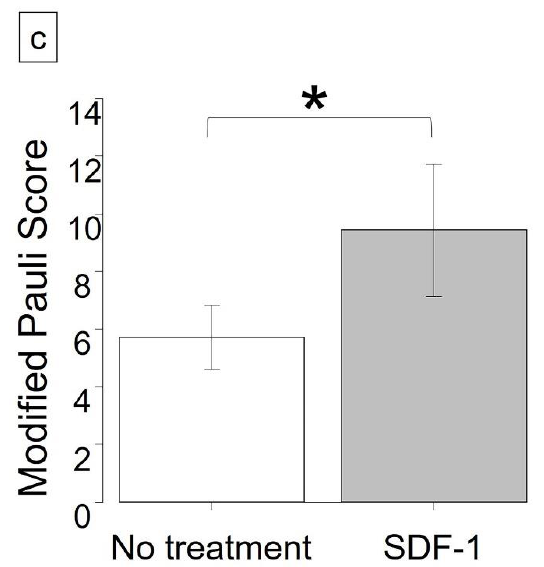
Figure 2. ( a ) Histological findings 1 week after meniscectomy. Hematoxylin and eosin (H–E) staining of the reparative meniscus revealed a mixture of mononuclear cells (arrows) and spindle-type cells (arrowheads). Toluidine blue staining revealed no metachromasia in either